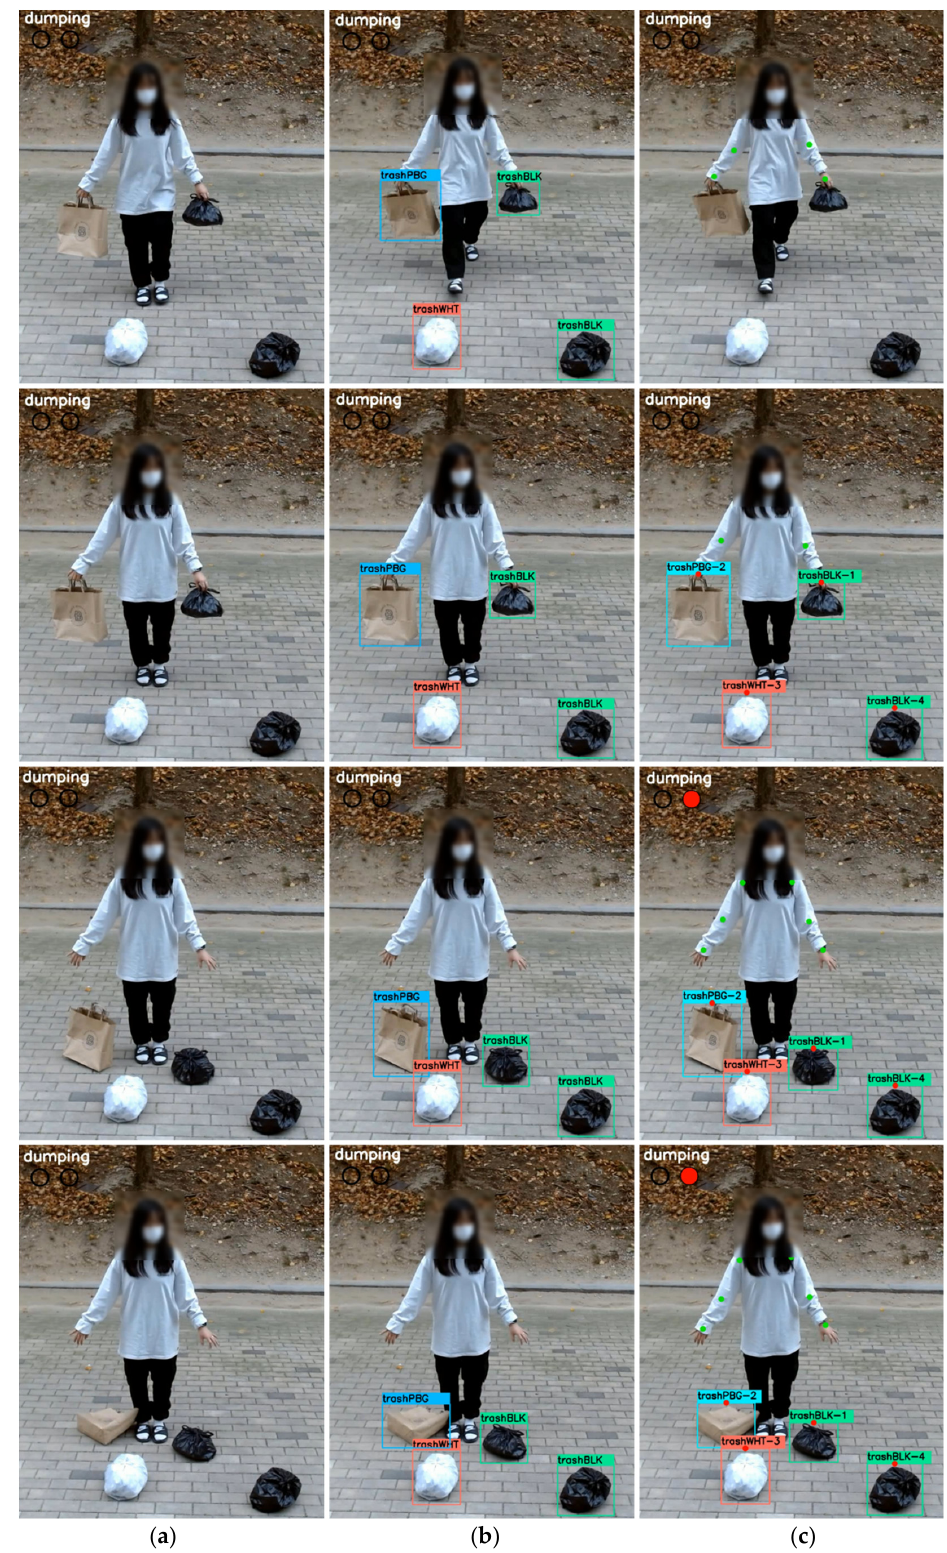
Figure 7. Examples of the findings from the monitoring models for rubbish disposal without body bending; ( a ) [7], ( b ) Post+det, and ( c ) Proposed AIDM.